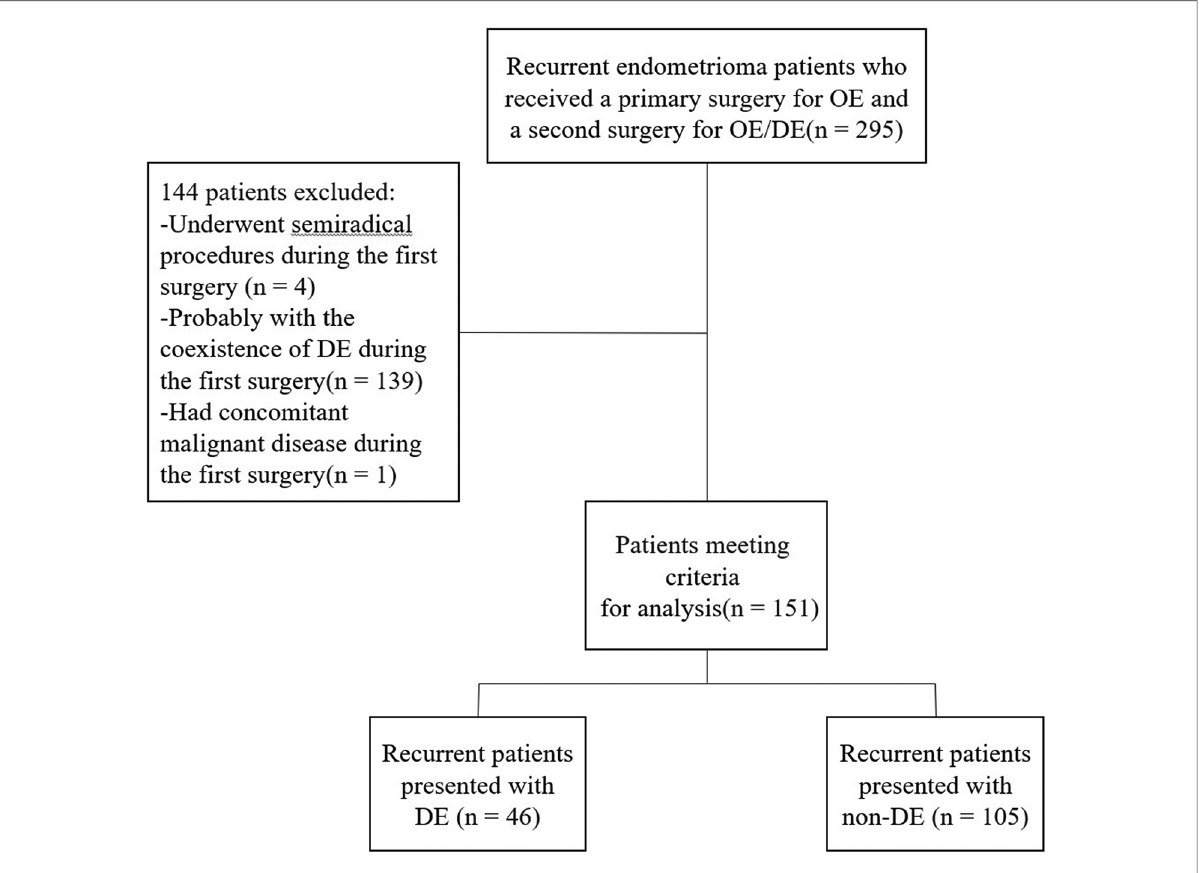
FIGURE 1 Flow diagram of patient selection